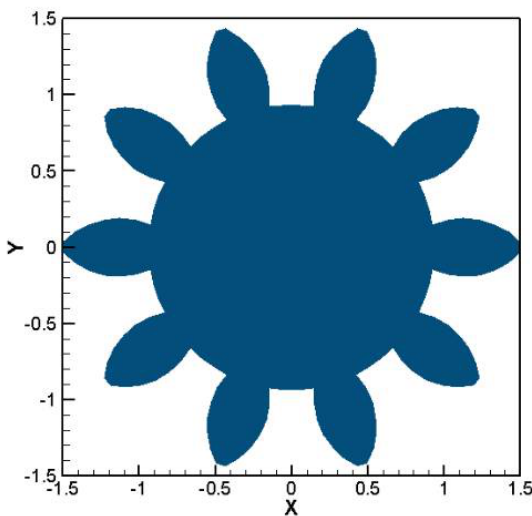
T x = x 2 , and T y = y 2 .